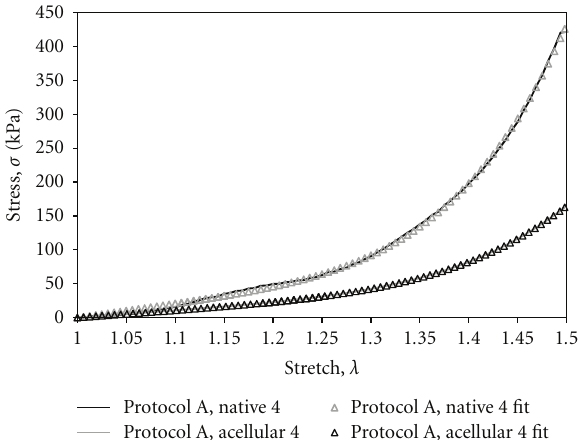
Figure 5: A representative plot of a paired data set and correspond- ing curve fits (4th load